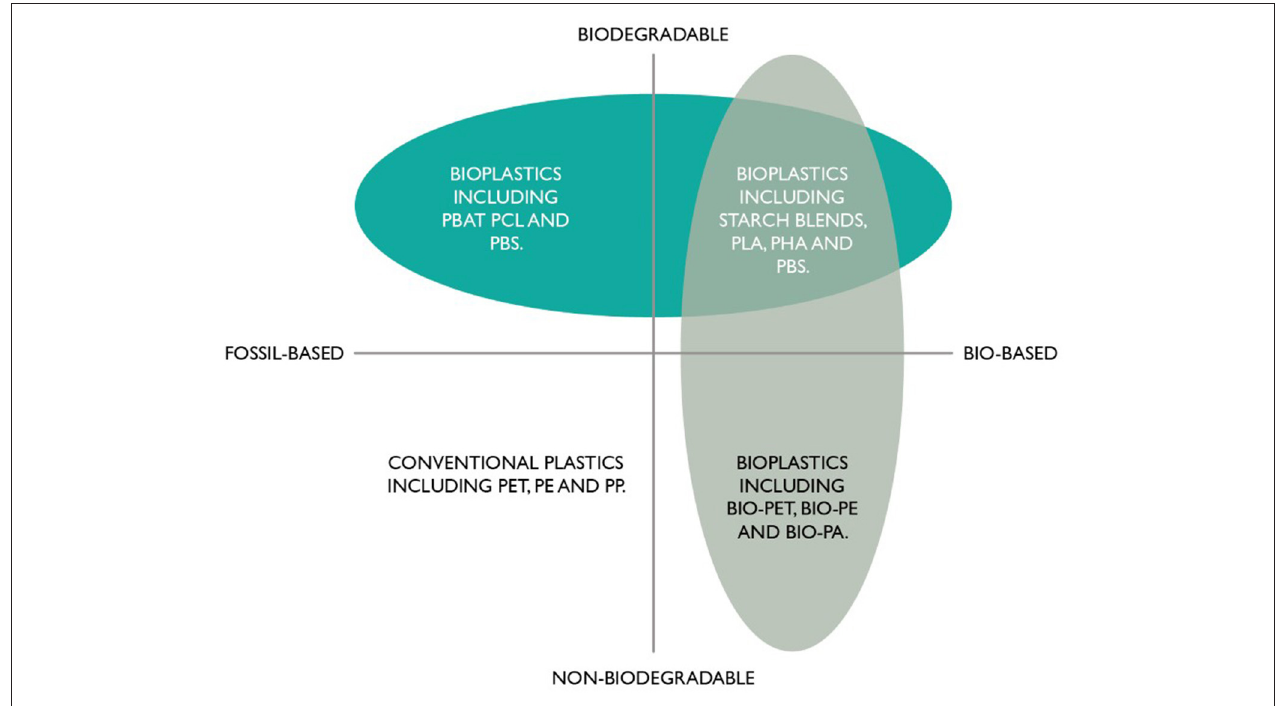
FIGURE 1 | Identification of bioplastics (Pathak et al., 2014).